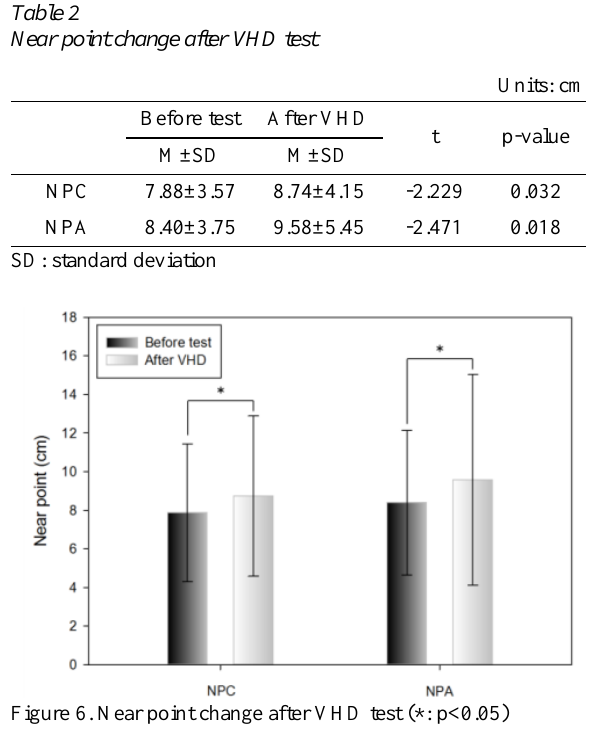
Changes in far and near phoria after the VHD test